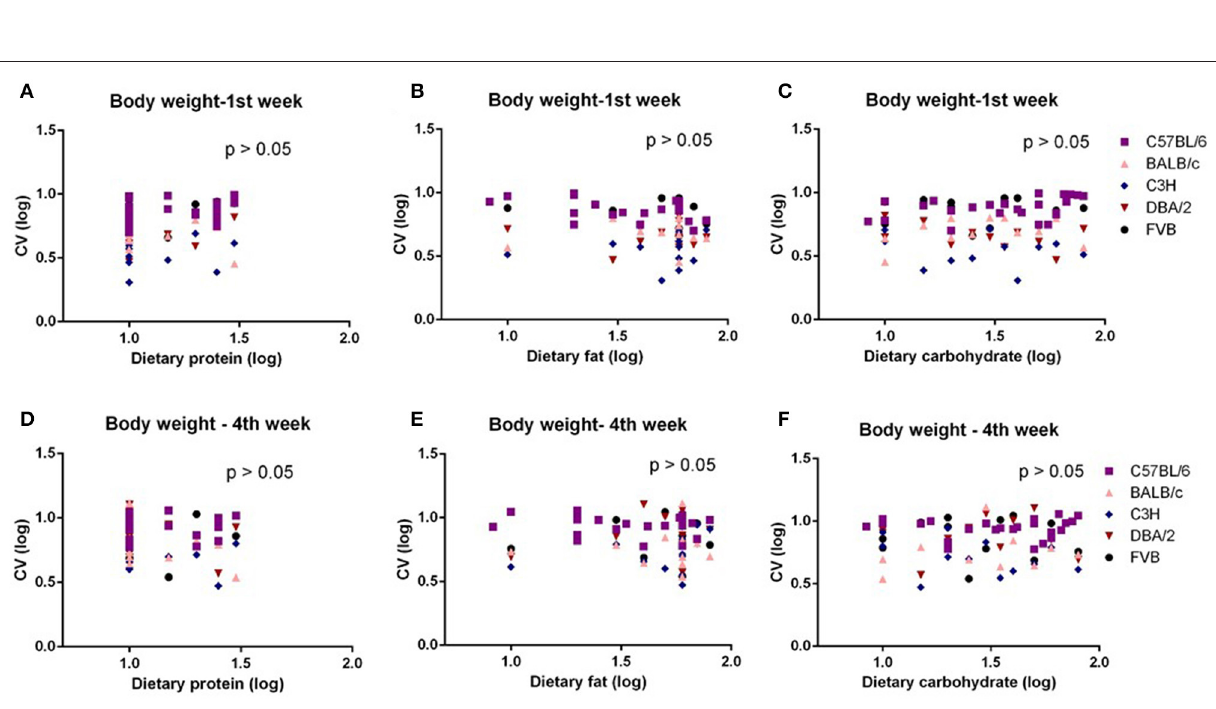
Frontiers in Nutrition |